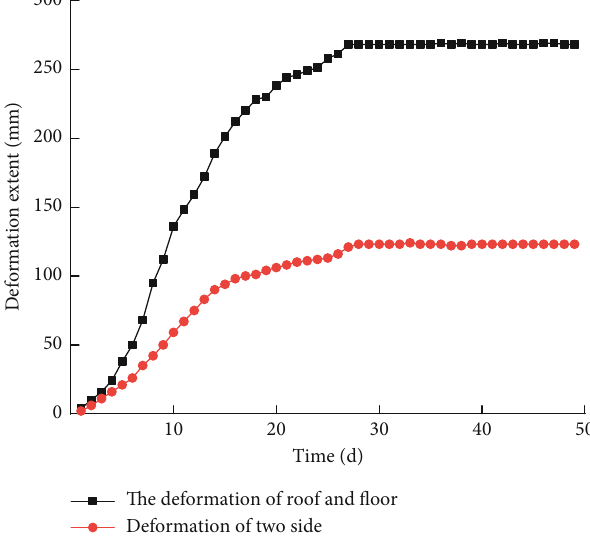
Figure 14: Change of surface displacement of